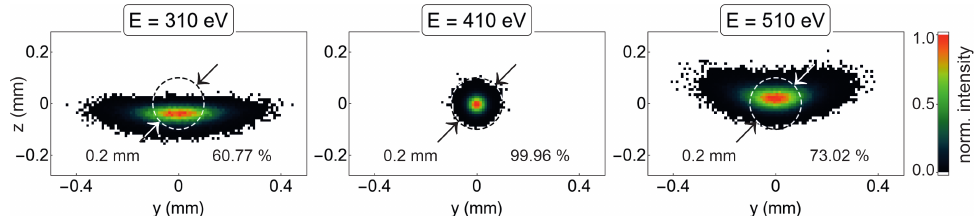
Figure 5. Normalized intensity distribution, obtained by Monte Carlo RT, for three photon energies in the sample plane (Figure 1), assuming a source size ∅ src = 50 µ m (FWHM). The relative flux ( % ) inside the dashed circle with a diameter ∅ = 0.2mm is noted in the lower-right corner of each